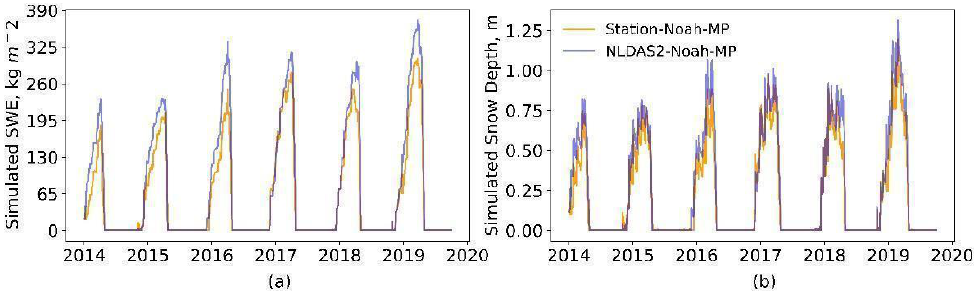
Figure 3. Simulated ( a ) Snow Water Equivalent; ( b ) Snow Depth, from Noah-MP Model versus Station-Noah-MP from WY 2014 – 2019.